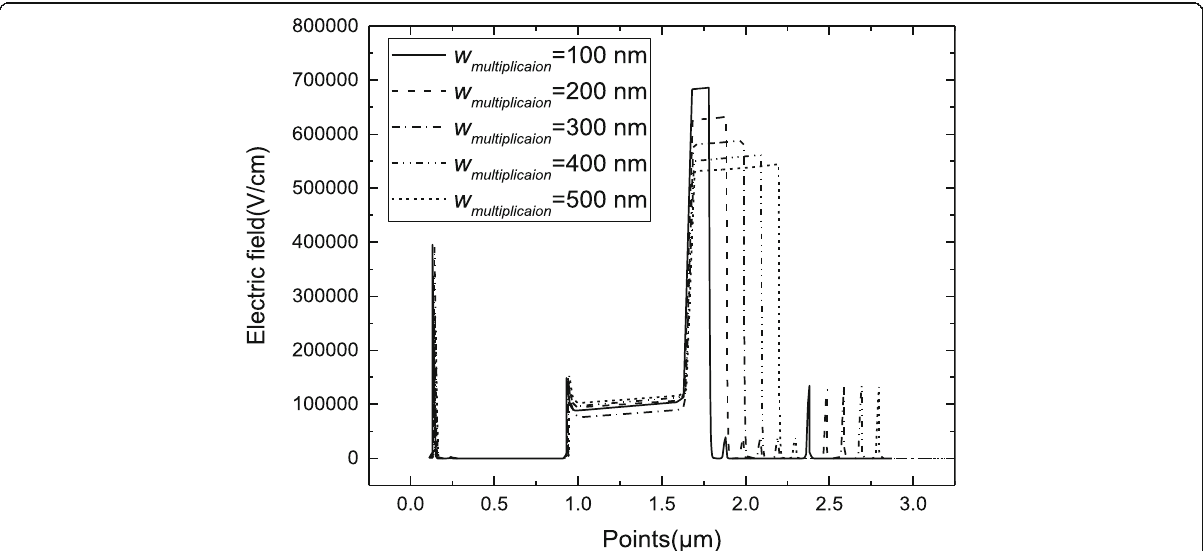
Fig. 6 Electrical field in the multiplication layer with different W multiplication . Figure 5 presents the simulated field-voltage characteristics for different multiplication thicknesses (100 – 500 nm) when the device undergoes avalanche breakdown